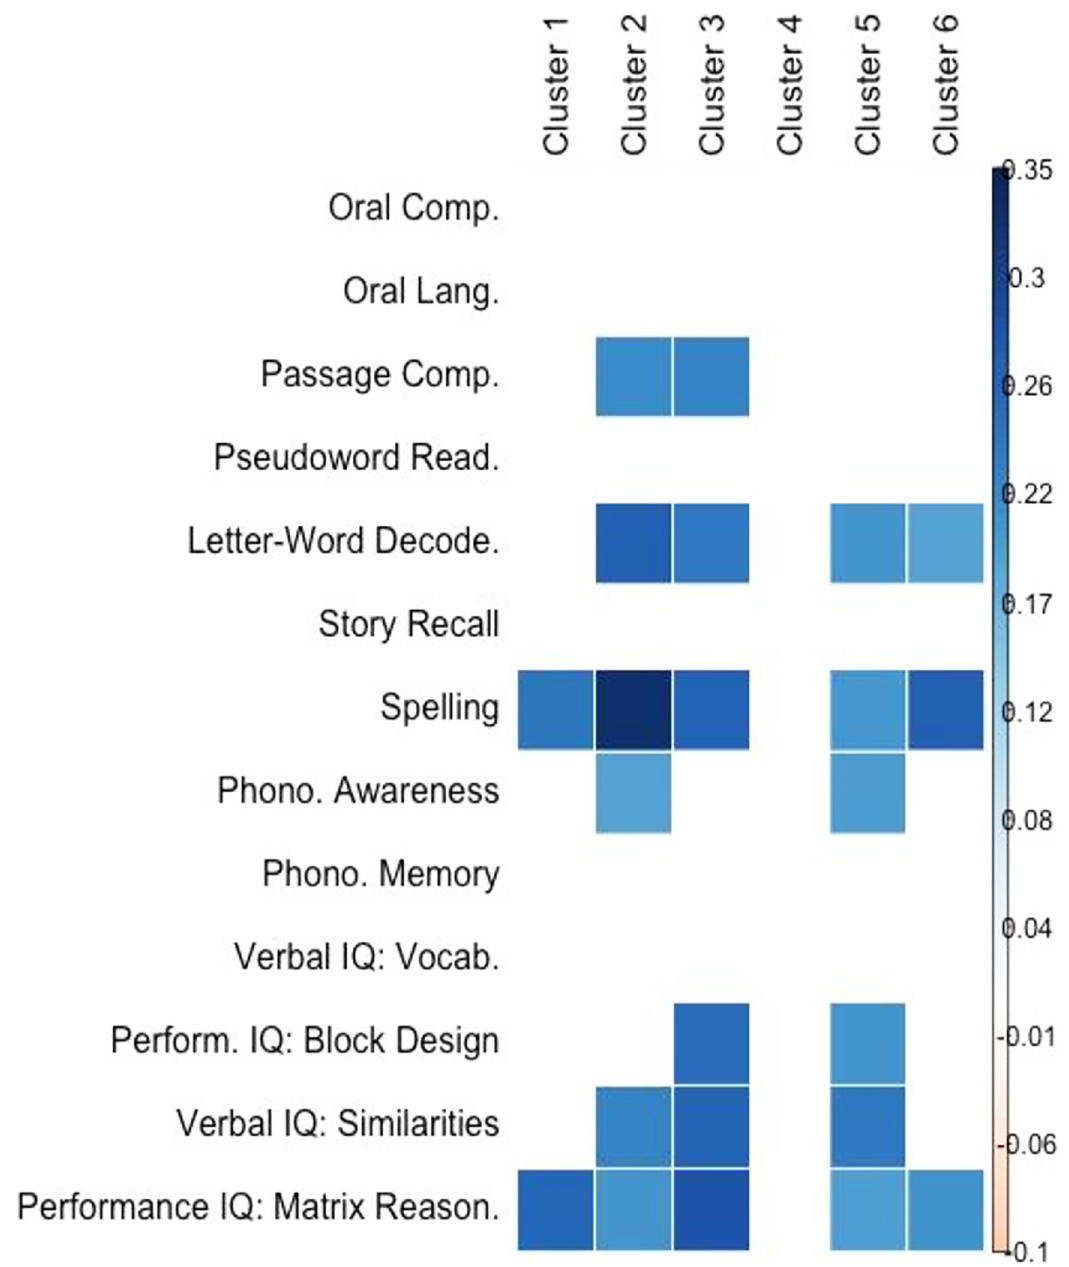
Fig 6. Brain-behavior correlations. Correlations between children ’ s performance on behavioral battery and mean activation in regions reported in Table 3 (regions where Met allele carriers showed greater activation than Val/Val homozygotes). All correlations are significant at p < .05, after permutation